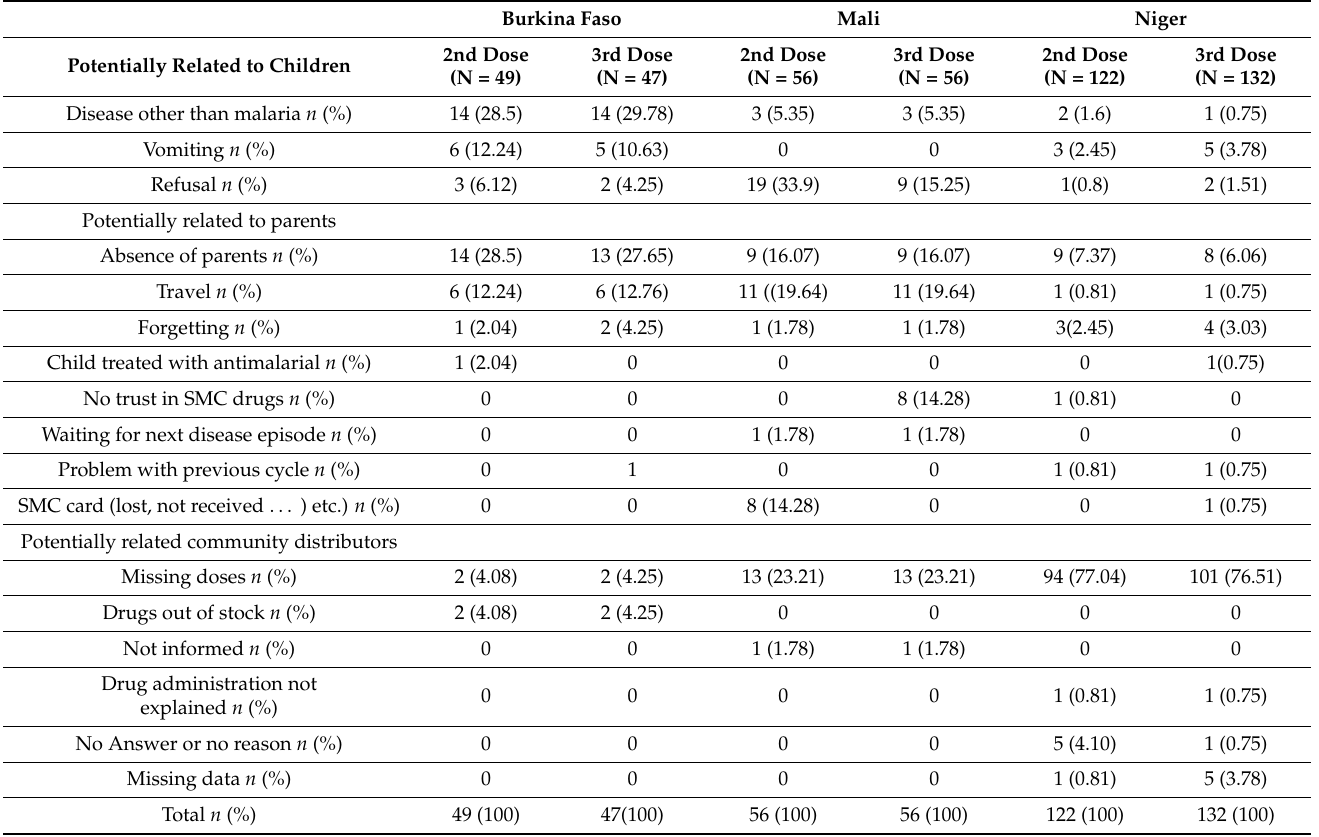
Table 3. Causes of non-adherence of the second and third doses in Burkina Faso, Mali and Niger. Burkina Faso Mali